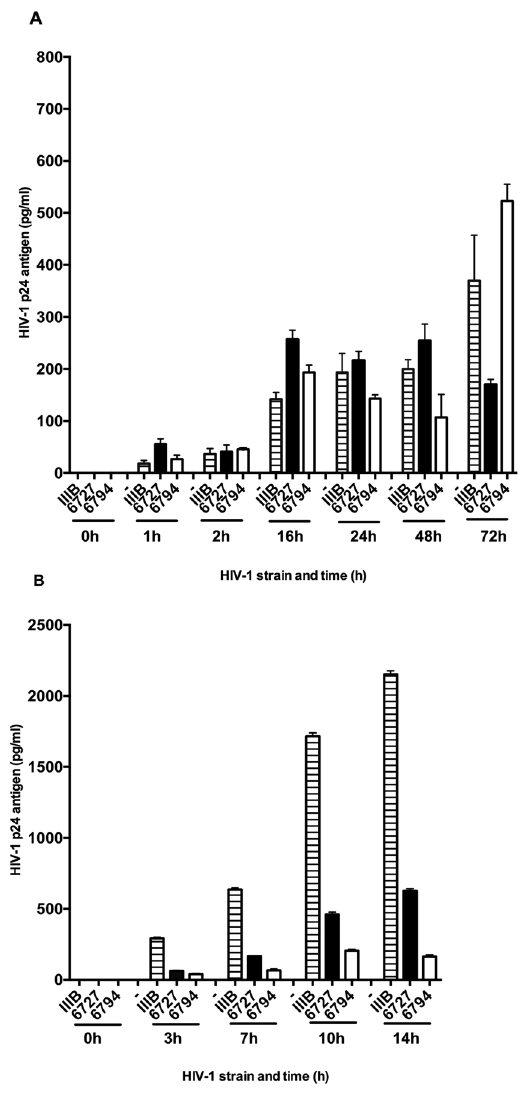
Figure 2. Transcytosis of HIV-1 from the apical to the basolateral side of the polarized epithelial cell membrane. Three HIV-1 isolates, the laboratory adapted HIV-1 IIIB/Lai strain and two primary HIV-1 clade B isolates, one non-syncytia-inducing strain NSI6727, and one syncytia-inducing strain SI6794, were added to the apical side of the Transwell cell culture system human epithelial cell line Caco-2-pIgR + . ( A ) Culture supernatants were collected from the basolateral side over a 72-h period and tested for HIV-1 p24 by ELISA. The median and interquartile ranges of HIV-1 p24 antigen concentration from two to three analyses/HIV-1 isolate are shown. ( B ) Infectivity of the transcytosed HIV-1 collected at the basolateral side was measured by the ability to infect human target cells in vitro . Jurkat T cells was used for HIV-1IIIB/Lai and IL-2/PHA-activated human PBMCs for the two primary HIV-1 clade B isolates. Basolateral supernatant with HIV-1 was incubated with 10 6 target cells for 24 hours before washed and cultured. Supernatants were collected over a 14 h period and the infection levels assessed by HIV-1 p24 antigen-specific